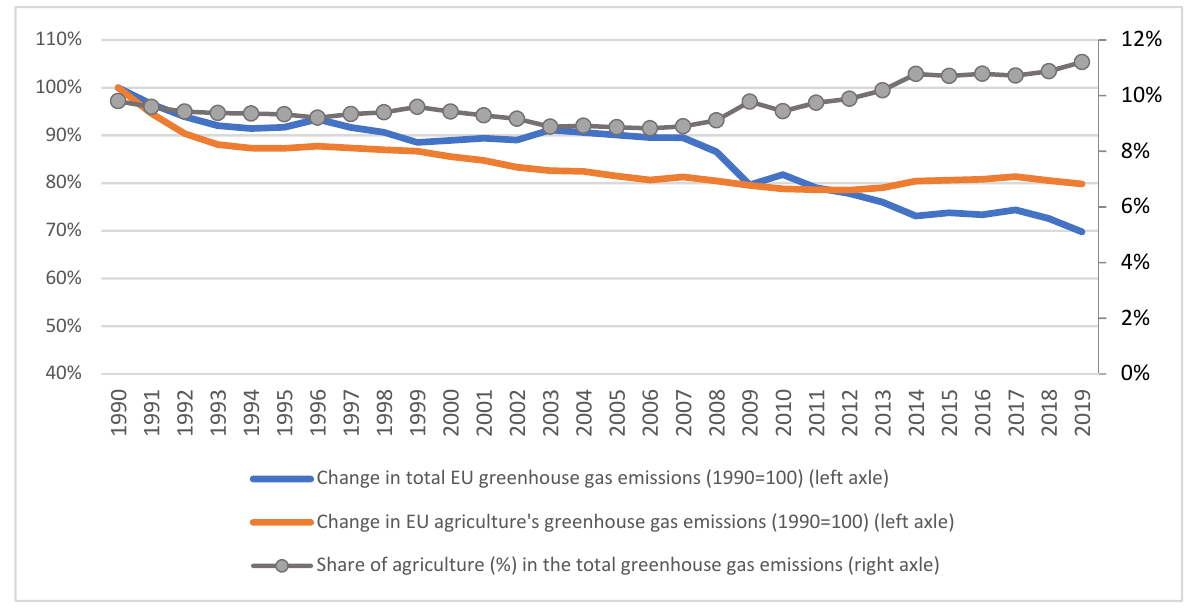
Figure 1. Change in EU-28 greenhouse gas emissions, 1990–2019 (1990 = 100). Source: European Environment Agency.